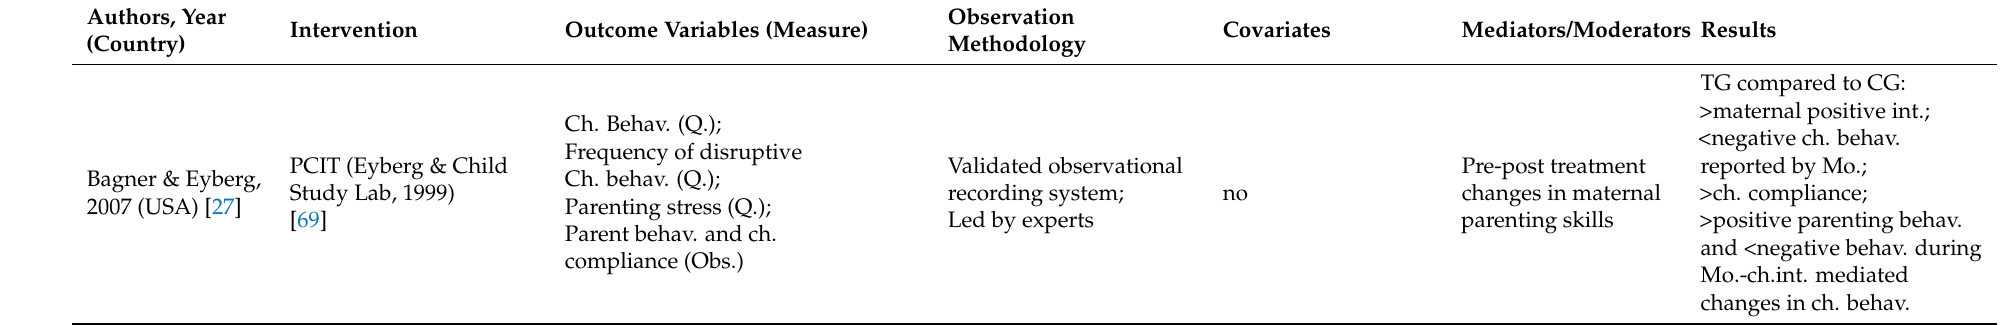
Table A2. Interventions’ outcome variables, measures and